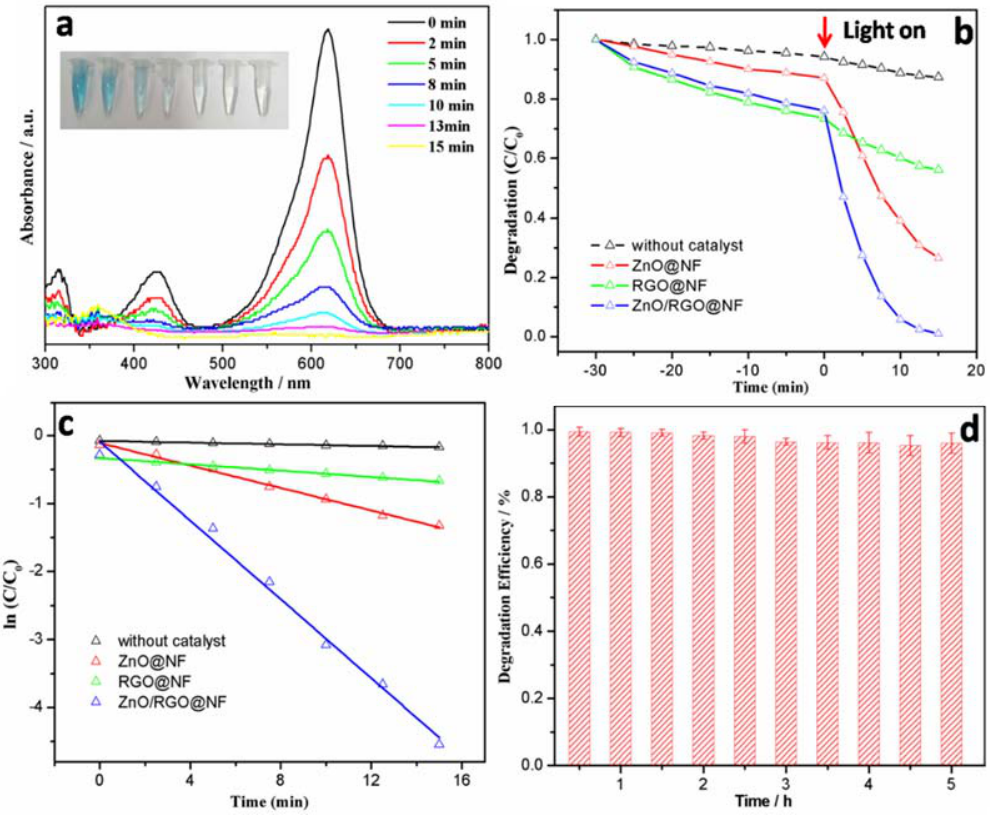
Figure 6. ( a ) The photocatalytic degradation process of malachite green (MG)(20 mg/L) in seawater in the presence of ZnO/RGO@NF under UV irradiation(the inset photo shows the color change of MG in seawater with time); ( b ) MG degradation (%) at different irradiation time and ( c ) first order kinetics plot of ln(C/C 0 ) versus irradiation time for MG degradation; and, ( d ) Degradation efficiency of ZnO/RGO@NF for continuous 5 h degradation of MG (10 mg/L) in seawater.